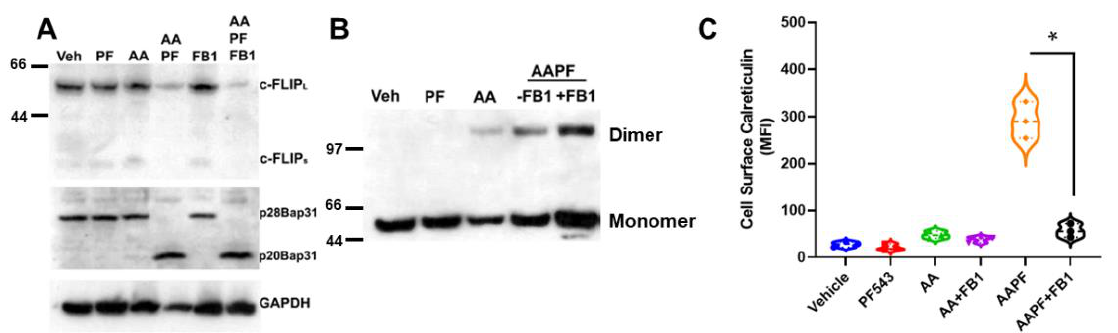
Figure 5. Cer is required for cell surface exposure of ectoCRT. ( A ). Inhibition of Cer synthesis using fumonisin B1 (FB1; 70 µ M) had no effect on ABT/AZD + PF-543 induced depletion of c-FLIP and cleavage of the Casp8 substrate, Bap31. ( B ). FB1 treatment enhanced dimerization of cell associated CRT in response to ABT/AZD + PF-543 treatment. ( C ). FB1 significantly reduced cell surface expo- sure of ectoCRT induced by ABT/AZD + PF-543 treatment. Statistical analysis was performed using one- way ANOVA followed by Tukey’s multiple comparison test. (* p ≤ 0.05 ) Asterisks indicate sig-